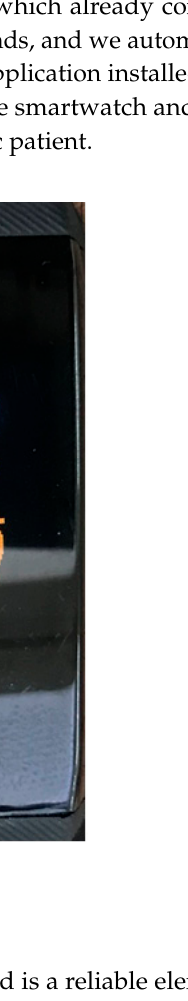
Table 2. Glucose, temperature and number of step measurement.